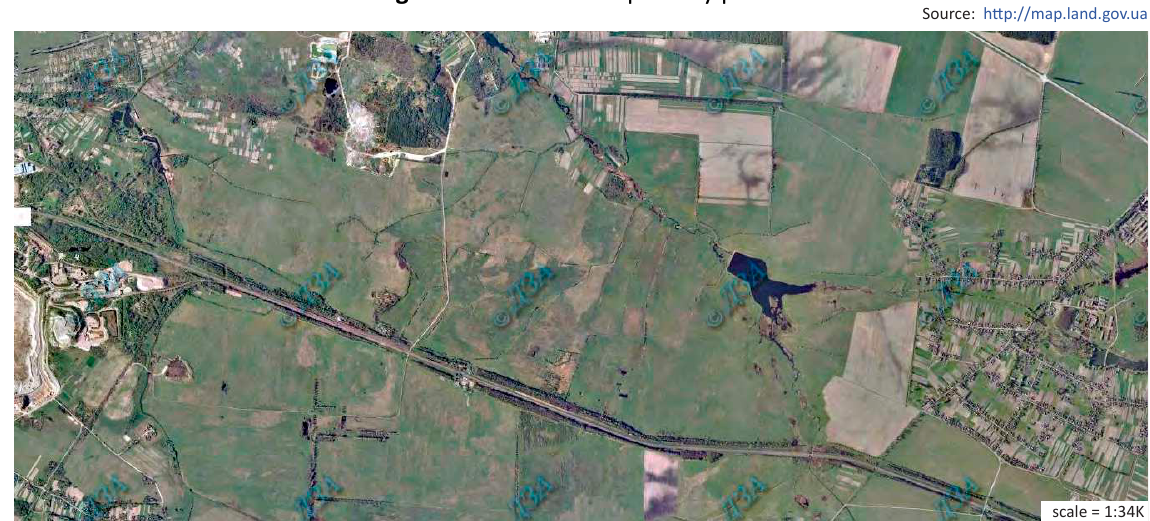
Figure 2. Orthophoto image of key plot 1